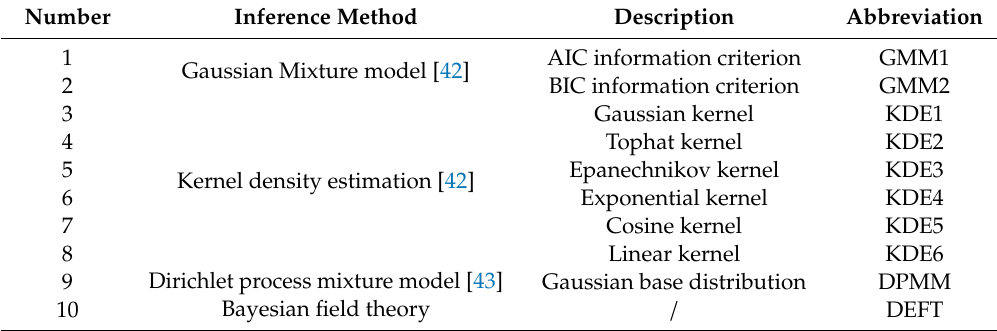
Table 3. The ten probability distribution inference methods for comparative analysis.